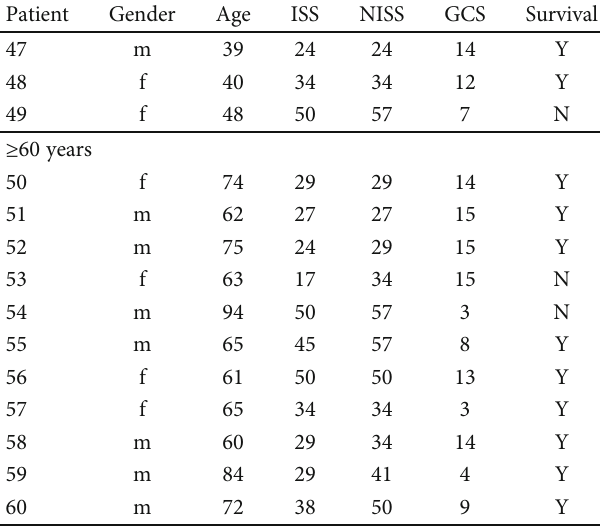
Table 2: Detailed patients ’ characteristics including gender, age, injury severity, initial GCS value, and survival ( n = 60 ). Patients are divided into two groups according to the cuto ff age of 60